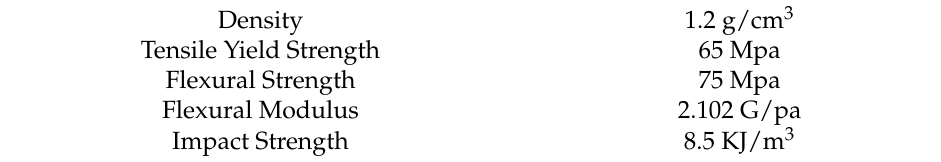
Figure 8. Finite Element Analysis results of leg parts. Table 2. Material Properties of the PLA plastic used for structural